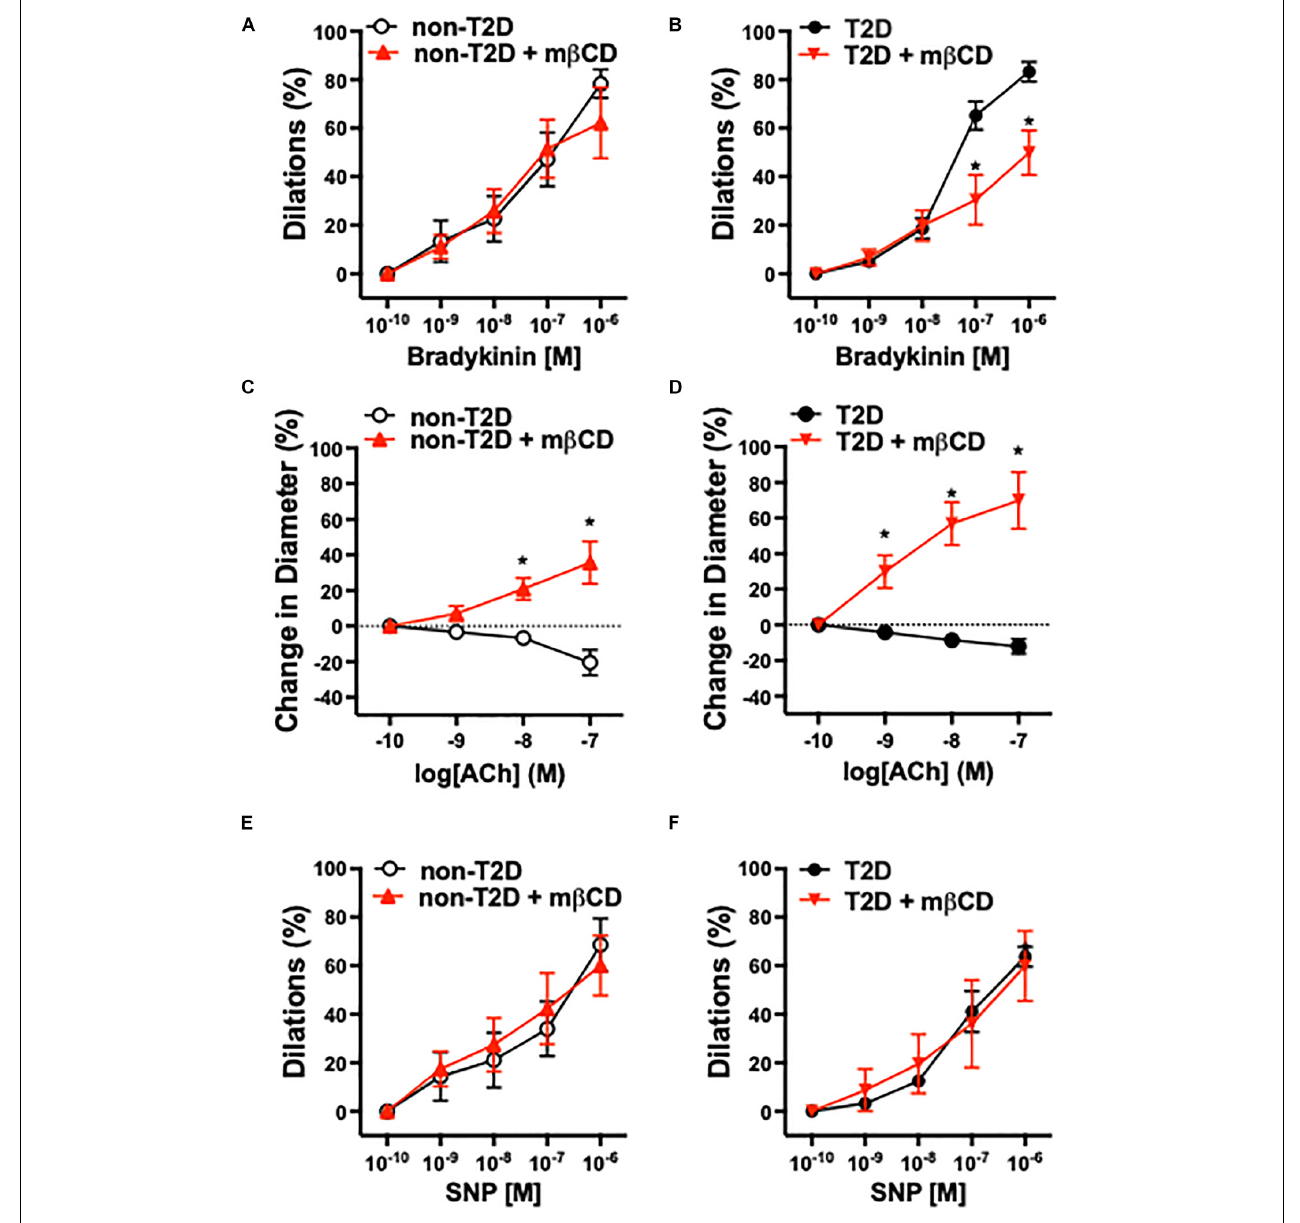
FIGURE 1 | Role of caveolae in human arteriole dilation in patients with T2D. Summary data of percent diameter changes of atrial coronary arteries from non-diabetic ( n = 5) (A,C,E) and T2D patients ( n = 5) (B,D,F) in response to cumulative concentrations of bradykinin (10 − 10 to 10 − 6 M), acetylcholine (ACh, 10 − 10 to 10 − 7 M) and the NO donor, sodium nitroprusside (SNP, 10 − 10 to 10 − 6 M), before and after incubation with methyl- β -cyclodextrin (m β CD, 2 × 10 − 3 M) for 60 min. * p < 0.05 before vs. after m β